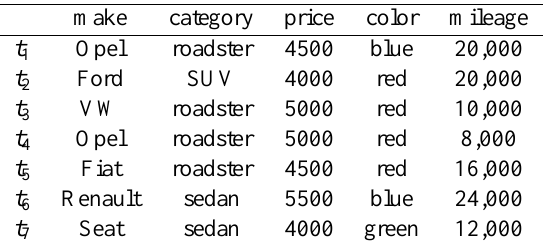
Table 1. An extension of relation car